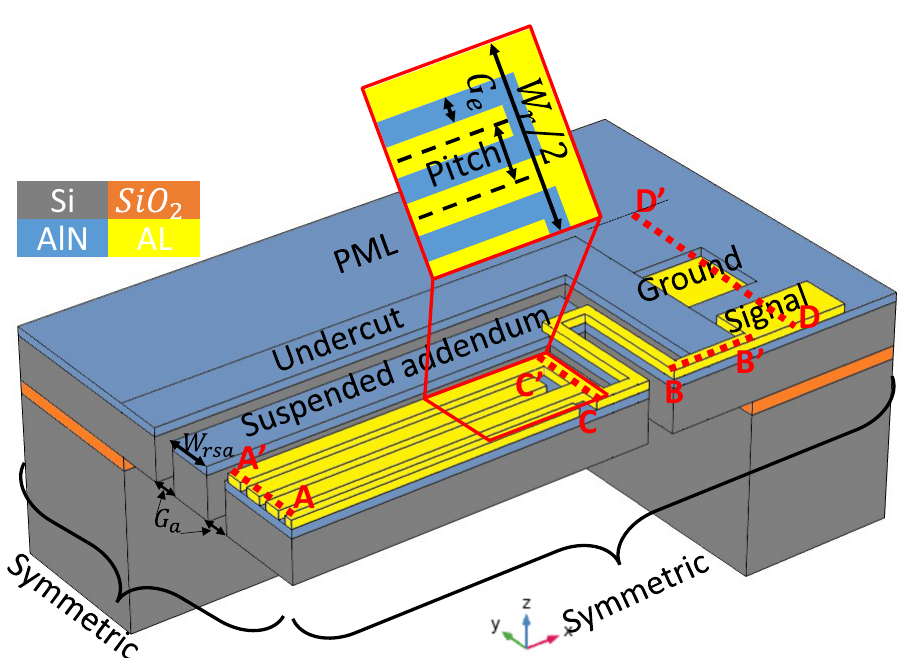
Figure 3. A mockup 3D view of a quarter plate resonator with an energy-preserving suspended addendum frame. Table 1. Resonator design parameters.